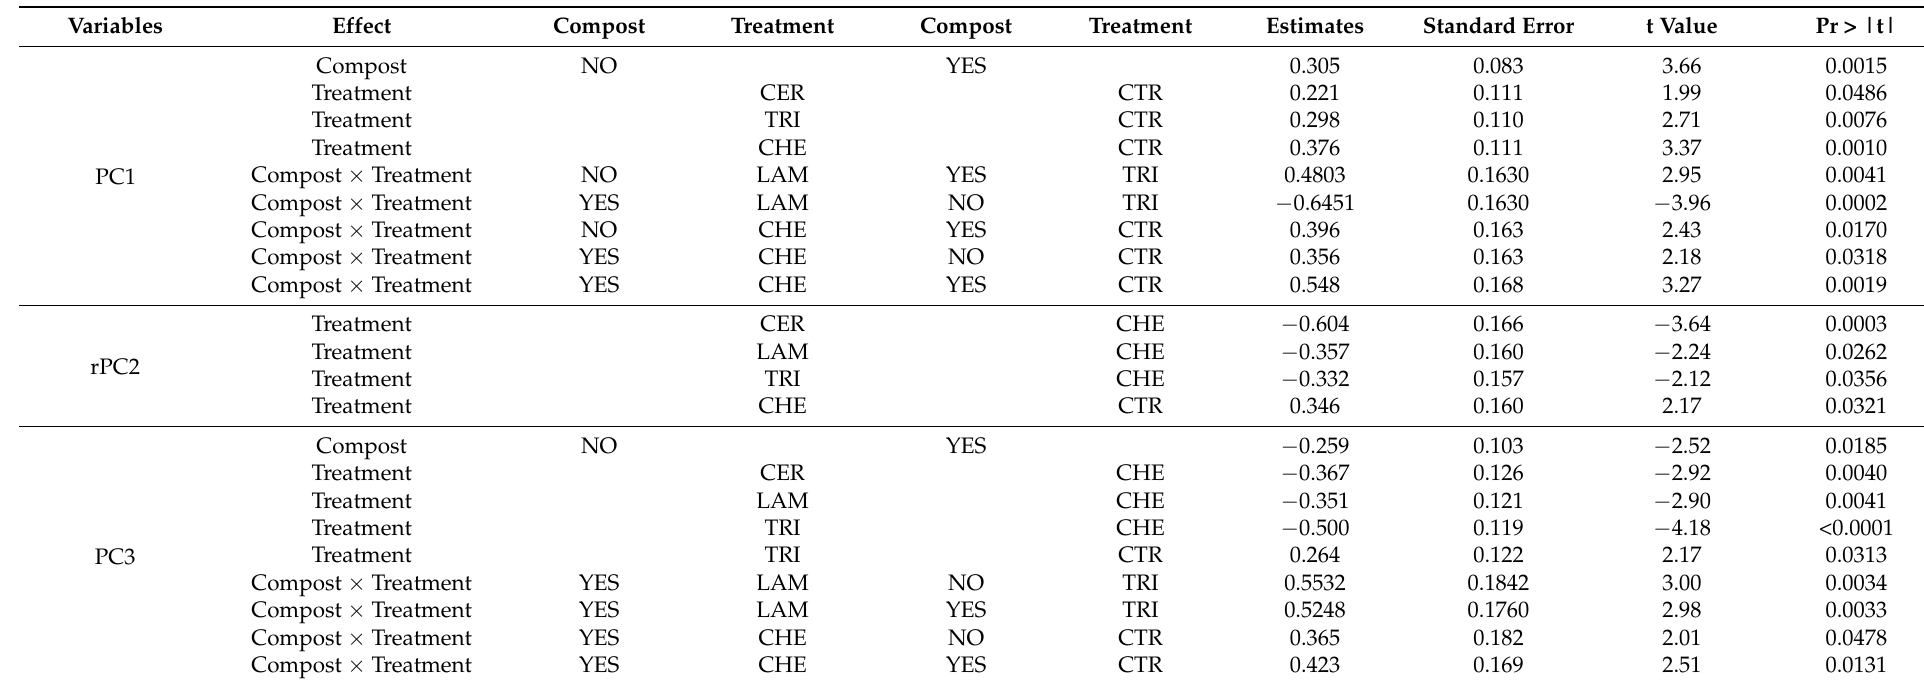
Table 7. The most relevant significative LSE differences between the levels of each effect and the ones of